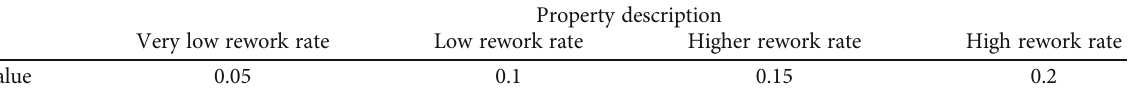
can be obtained.